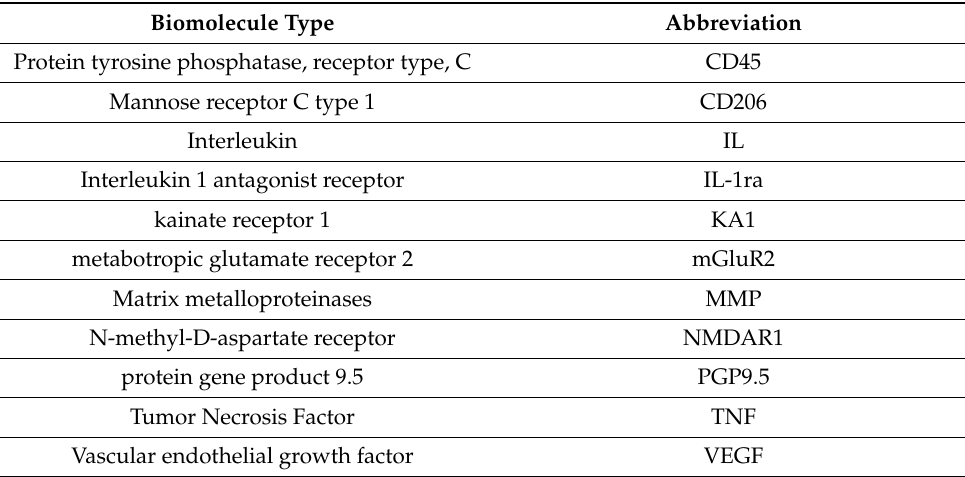
Table 1. List of abbreviations regarding biomolecule types. Biomolecule Type